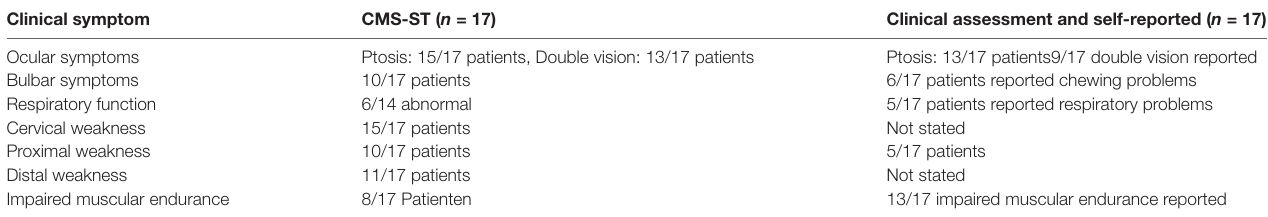
TABLE 2 | Results of standardized test (CMS-ST) in 17/21 patients compared to neurological assessment and reported symptoms by patients and their parents. Clinical symptom CMS-ST ( n = 17) Ocular